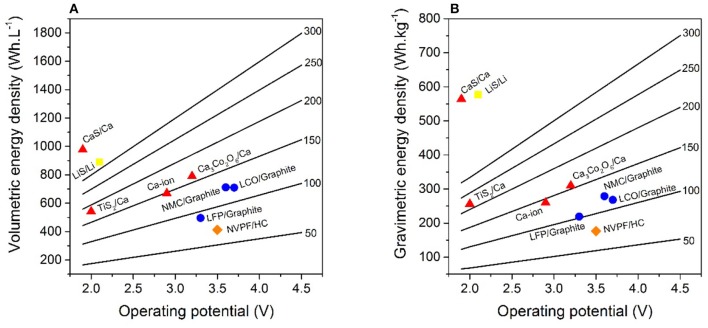
Volumetric (A) and gravimetric (B) energy densities for LIBs (circle), SIBs (diamond), Li-S (square), and considered Ca (triangles) battery technologies. The straight lines are calculated energy densities of hypothetical CaBs as a function of operation potential and capacities (denoted on the right of each line). All calculations were made using the model developed by Berg et al. (2015).